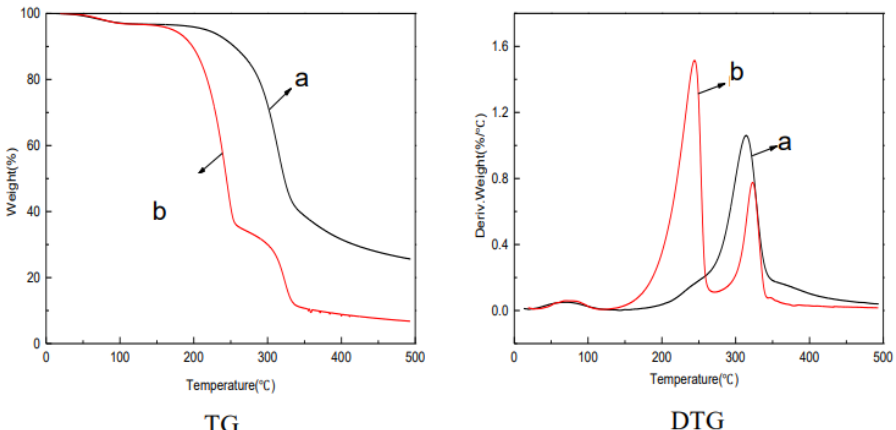
Figure 6. TG and DTG graphs: jute MCC ( a ) and jute MCC membrane formed in water as coagulation baths with 7 wt% of MCC ( b ).